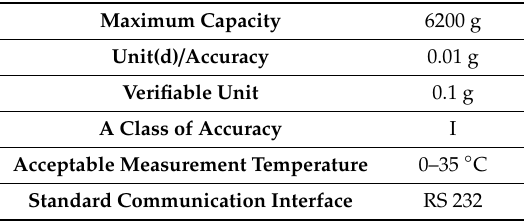
Table 5. Technical specification of Vibra AJ